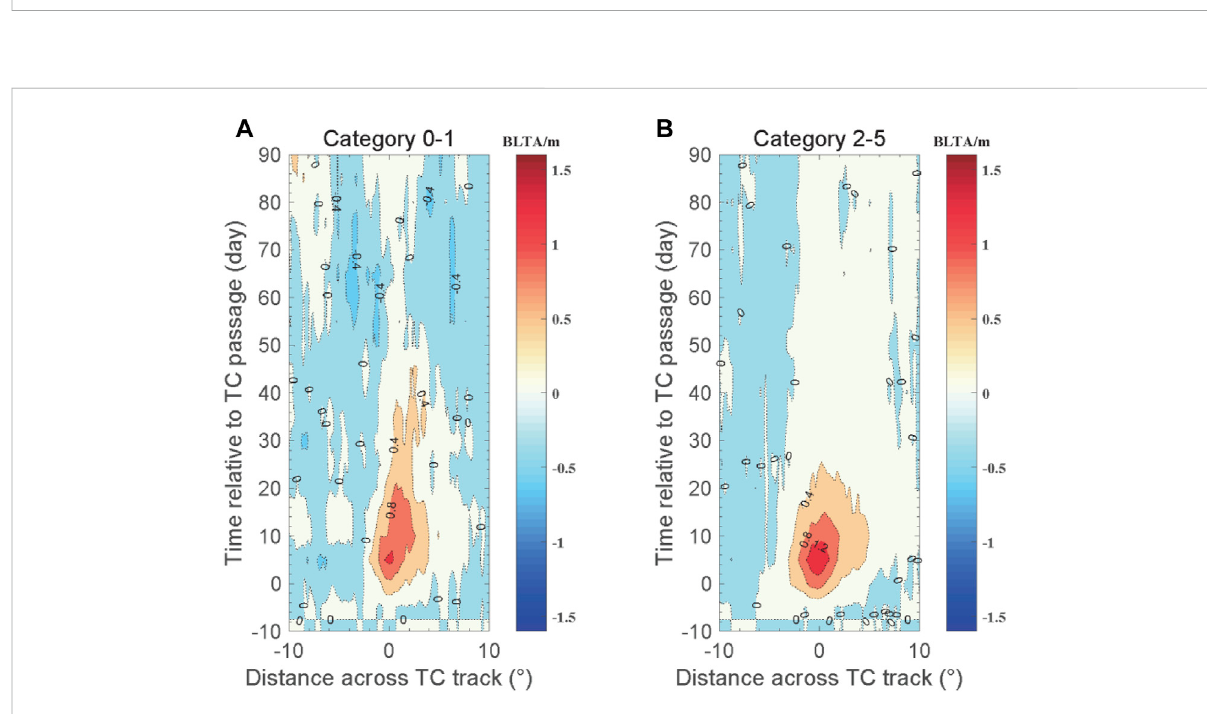
The temporal evolution of the along-track-averaged composite barrier layer thickness anomaly (m) under different TC